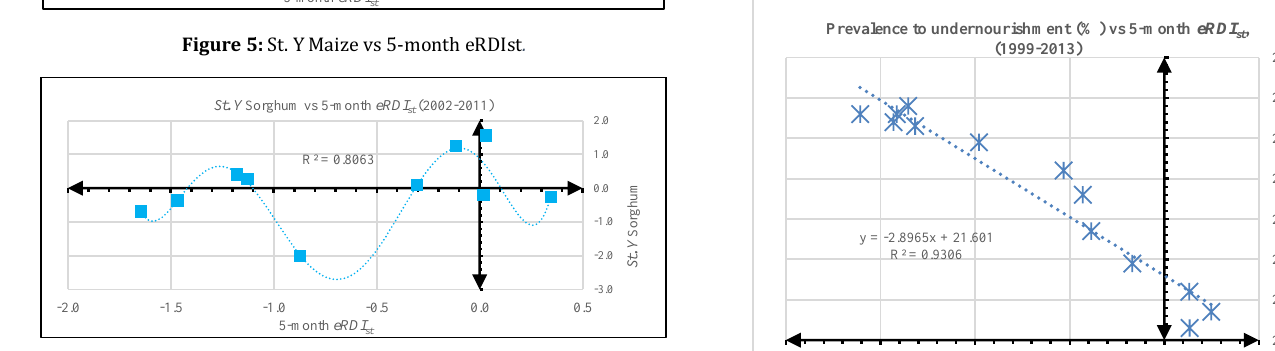
Figure 6: St. Y Sorghum vs 5-month eRDIst